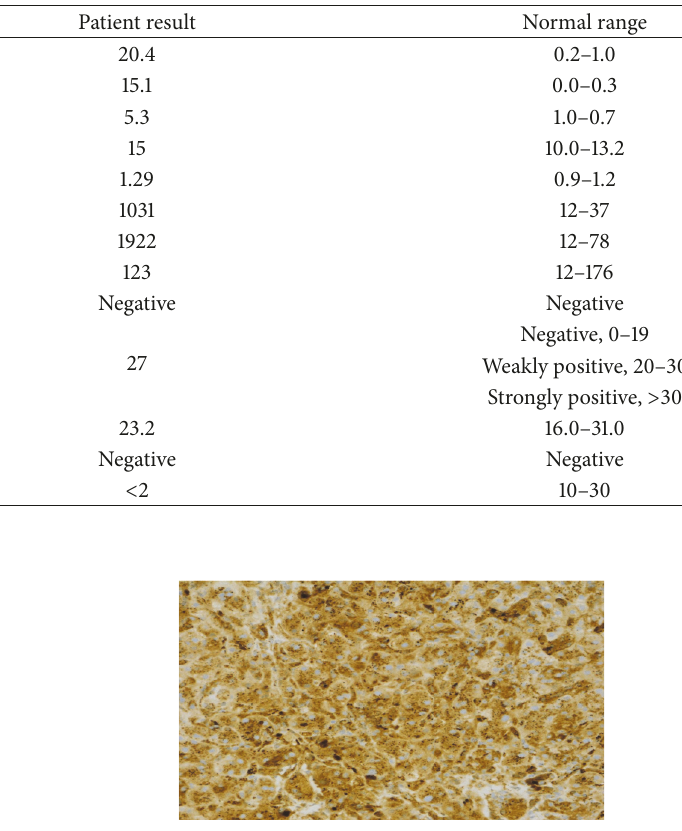
Figure 2: Immunohistochemistry for alpha-1-antitrypsin proteins. Diffuse strong positivity within hepatocytes and Kupffer cells indi- cated by the brown staining. IHC, ×